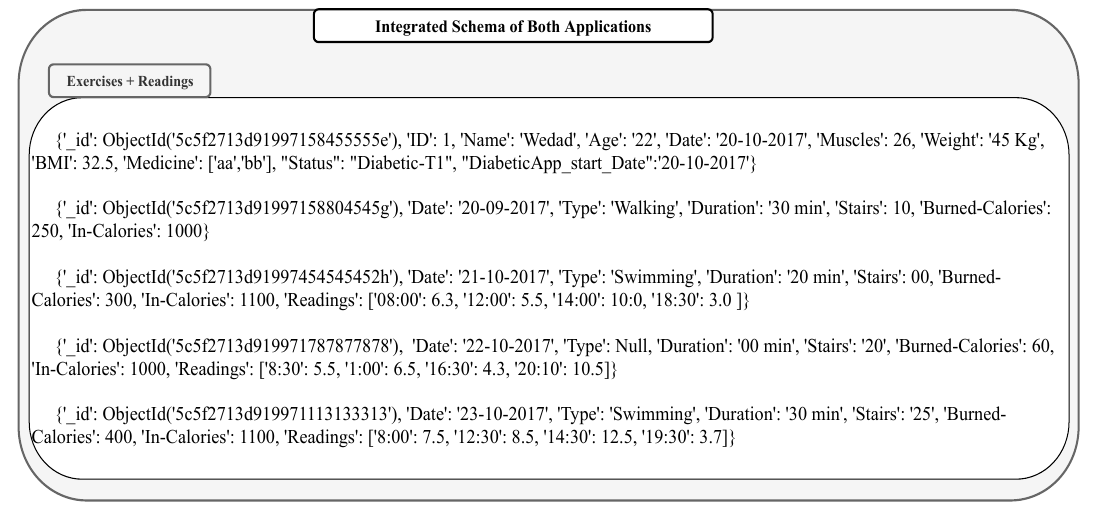
Figure 12. Integrated Result of Diabetic and Exercise